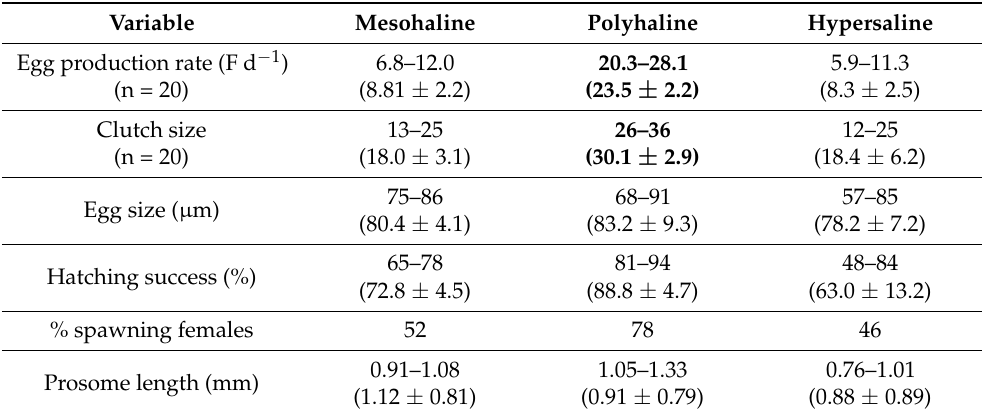
Table 2. Estimates of egg production rate, clutch and egg size, hatching success, and prosome length for the egg sac-spawning calanoid copepod Pseudodiaptomus hessei under varying salinity conditions in the temporarily open/closed Kasouga Estuary located on the southeastern coastline of South Africa. Values in brackets are the mean and SD values; n = number of replicates. Variable Mesohaline Polyhaline Hypersaline Egg production rate (F d − 1